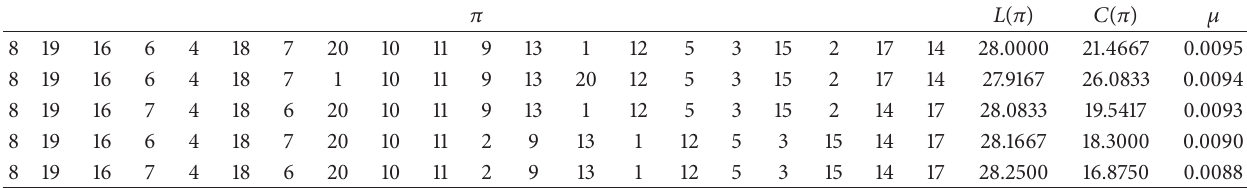
Table 4: The best five solutions with largest 𝜇 obtained by MOABC/D on instance